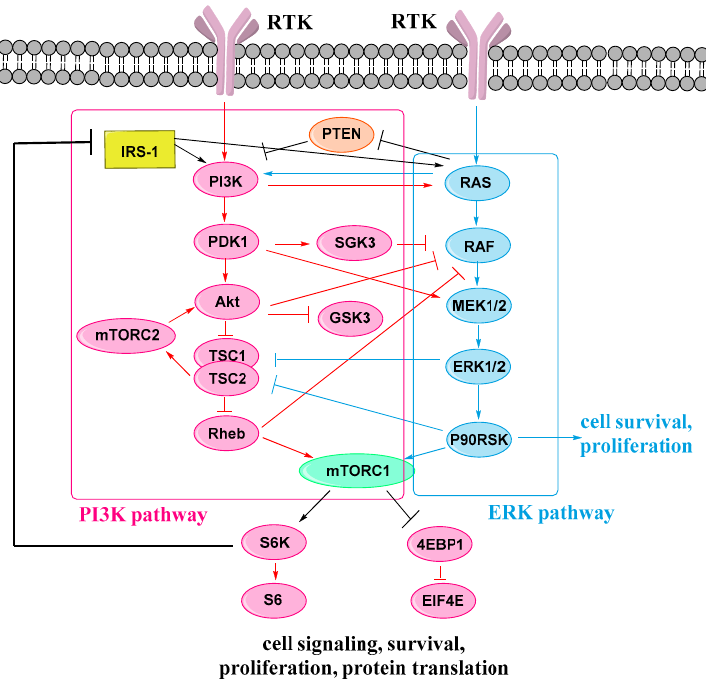
Figure 3. The cross-talk between MAPK/ERK and PI3K/Akt pathways.